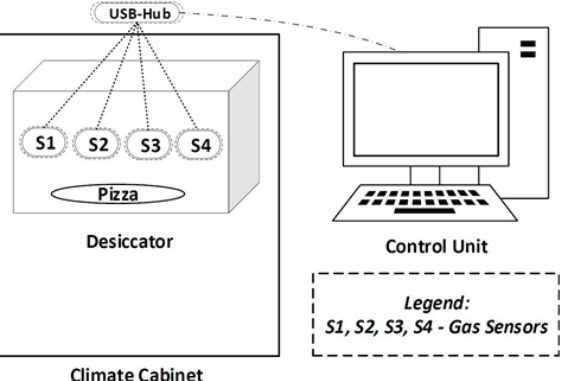
Figure 2. Measurement